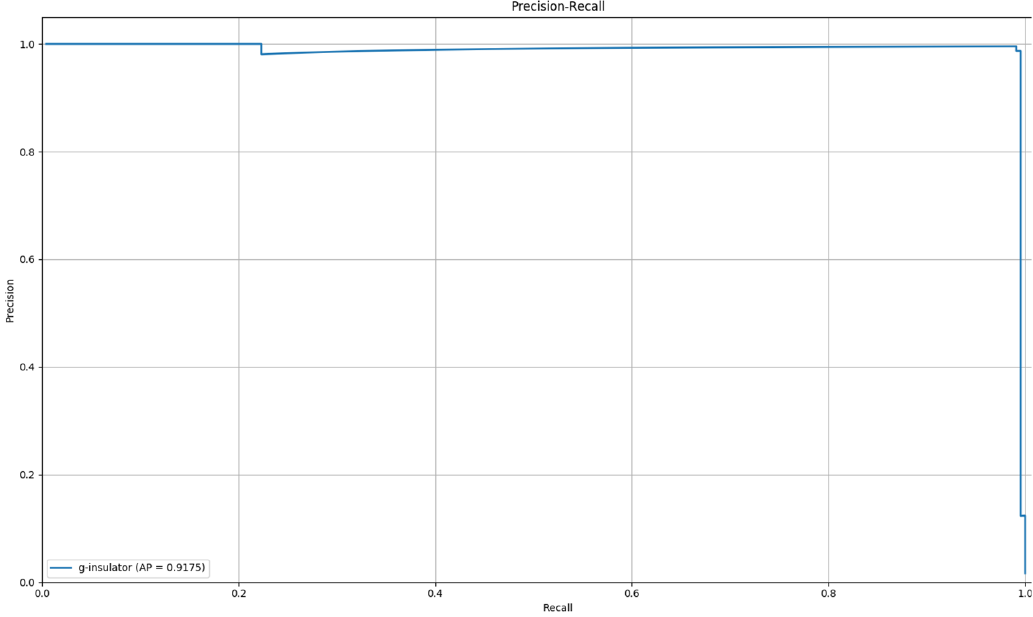
Figure 10. Detection of missing insulator